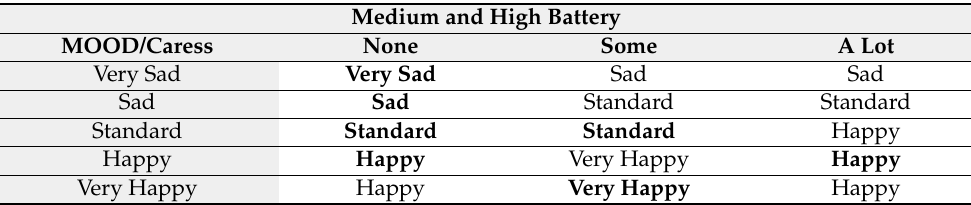
Table 8. Table of caress/MOOD rules for medium and high batteries. The gray cells represent the different MOOD and Caress labels defined. Bold respresents steady states.